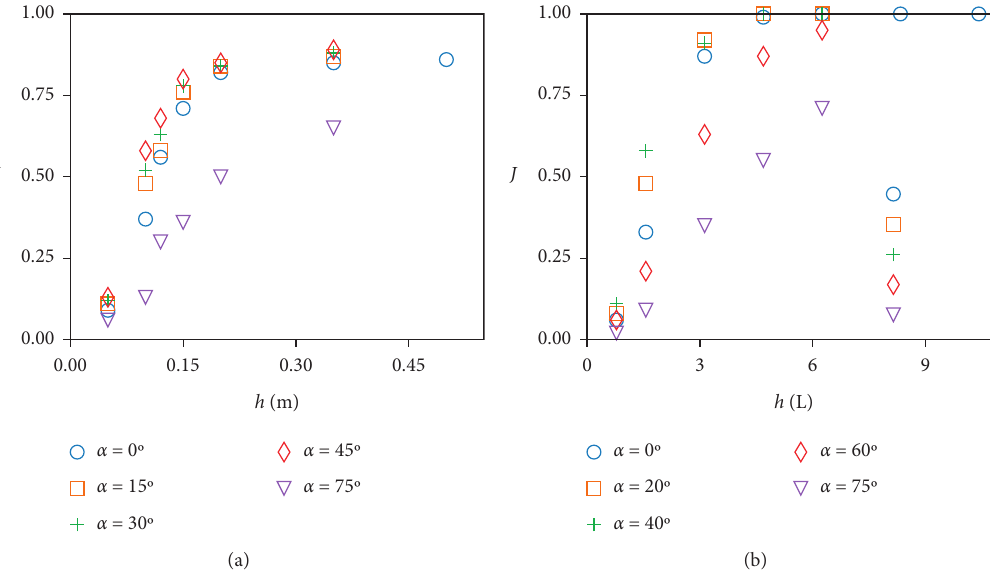
Figure 5: Results of clogging probability J versus pebble bed height h for various tilt angles α obtained by (a) experiment and (b)